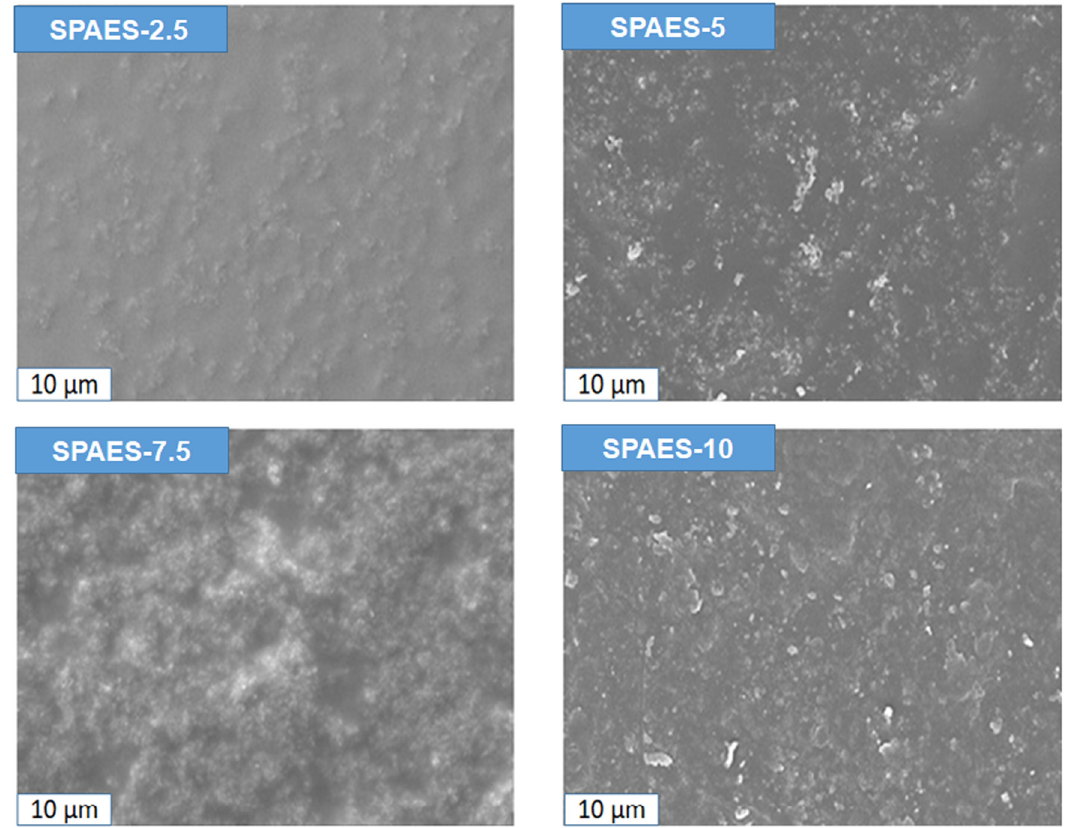
Figure 7: SEM images of SPAES - SS - X composite